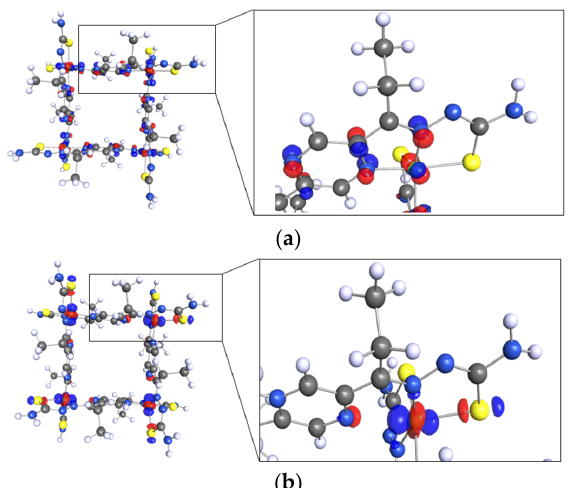
Figure 8. DFT (RI-)BP86/def2-TZVP calculated LUMO ( a ) and HOMO ( b ) of [Ni 4 (L Et ) 4 Figure 8. DFT (RI ‐ )BP86/def2 ‐ TZVP calculated LUMO ( a ) and HOMO ( b ) of [Ni 4 (L Et ) 4 ].